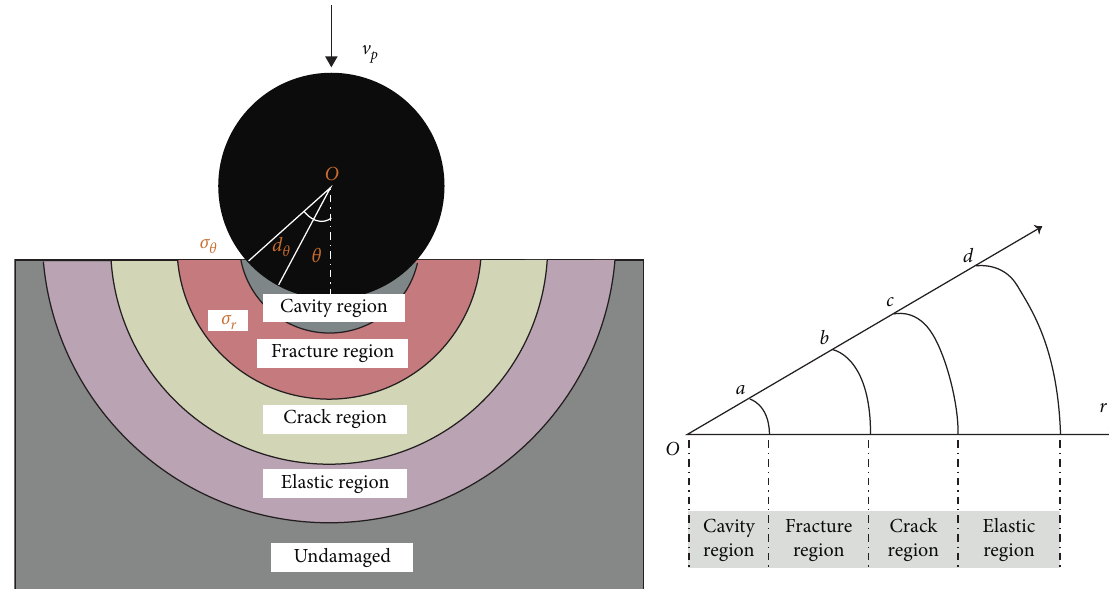
Figure 4: Dynamical damage response of rock under particle